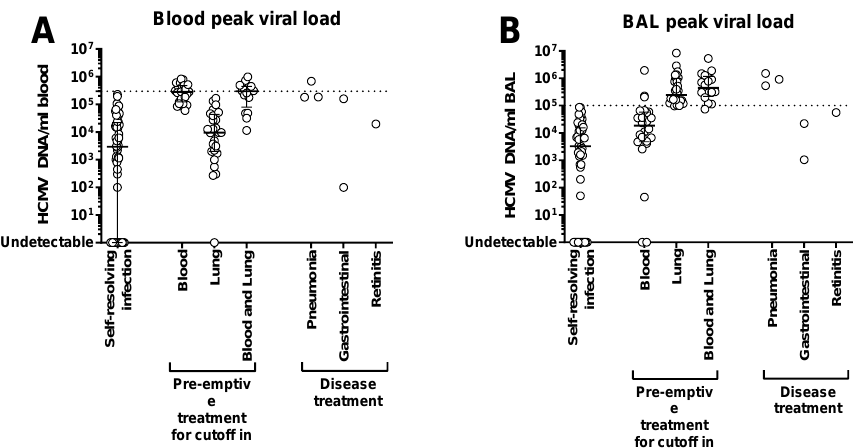
Figure 1. Peak levels of CMV DNA in ( A ) blood or ( B ) BAL of lung transplant recipients with self-resolving or no infection, pre-emptively treated for asymptomatic infection or treated for CMV disease. Each dot represents a patient. Median level and interquartile range are shown.